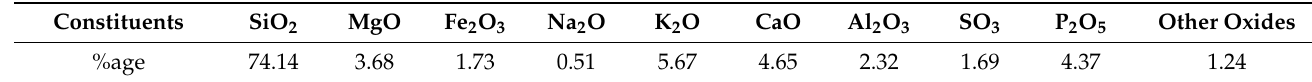
Table 3. SCBA chemical composition.